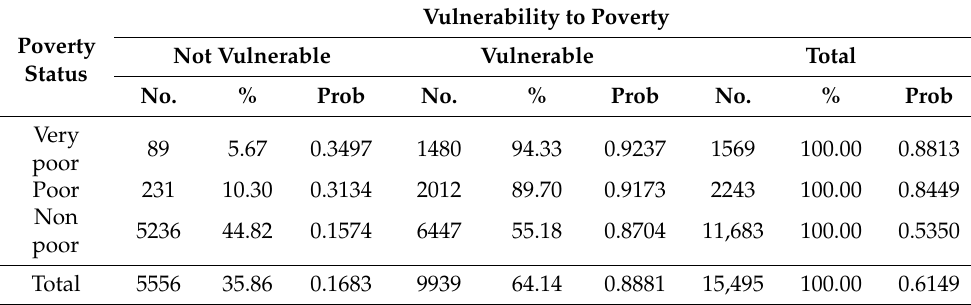
Table 5. Vulnerability without Social Expenditure, 2012/2013.